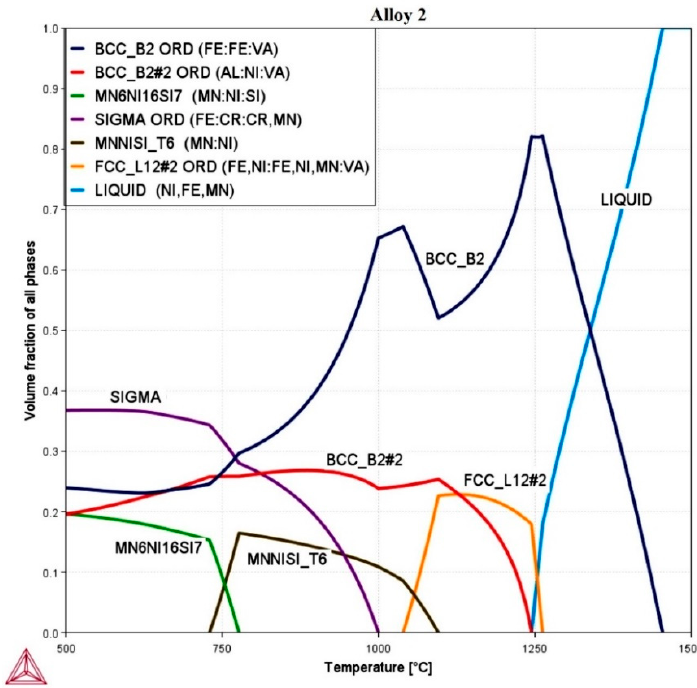
Figure 3. Phase diagram of Alloy 2 (Fe 35 Mn 15 Ni 20 Cr 15 Al 10 Si 5 ) HEA.